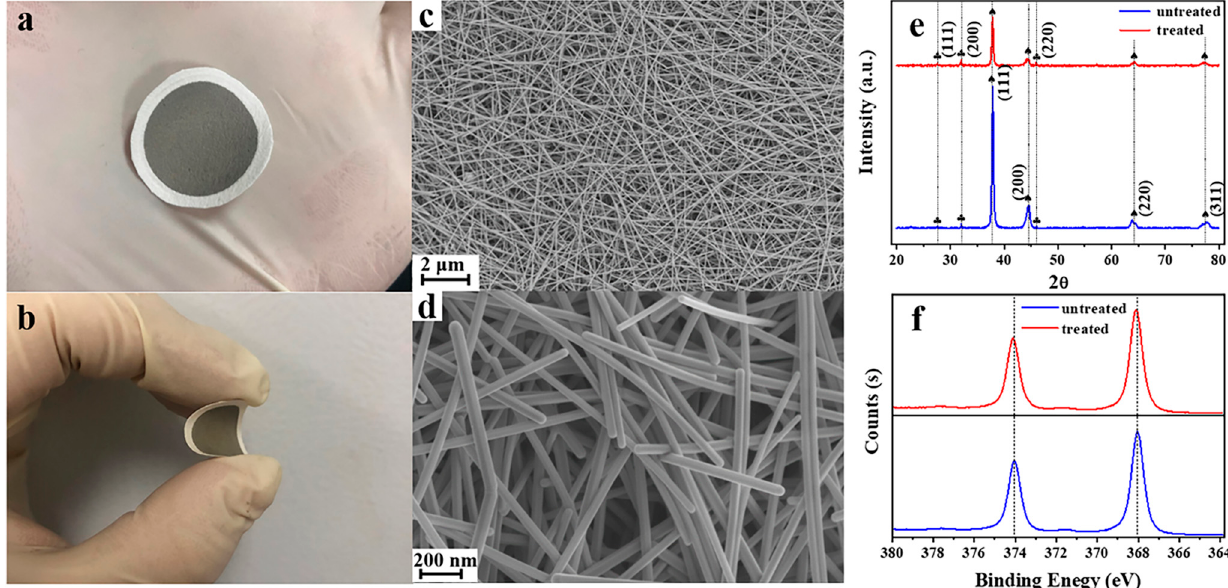
Figure 1. Optical photos of flexible silver nanowire membrane ( a , b ). ( c ) Low- and ( d ) high-magnification SEM images of a silver nanowire membrane. XRD patterns of the silver nanowire membrane before and after cyclic voltammetry (CV) treatment (cycle number: 15; temperature: 20 °C) ( e ) and the XPS of the silver nanowire membrane before and after CV treatment (cycle number: 15; temperature: 20 °C) ( f ).